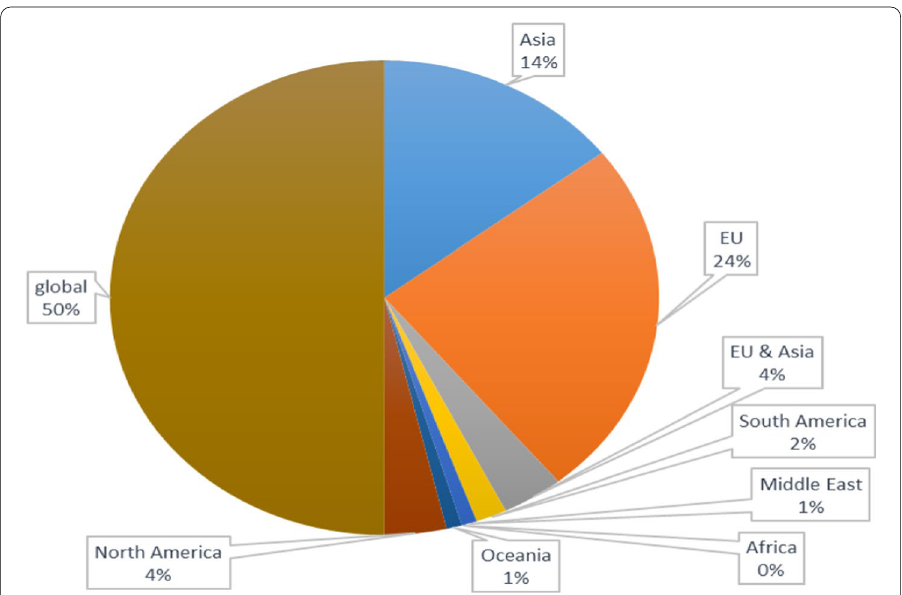
Fig. 3 Precentage of studies’ regional